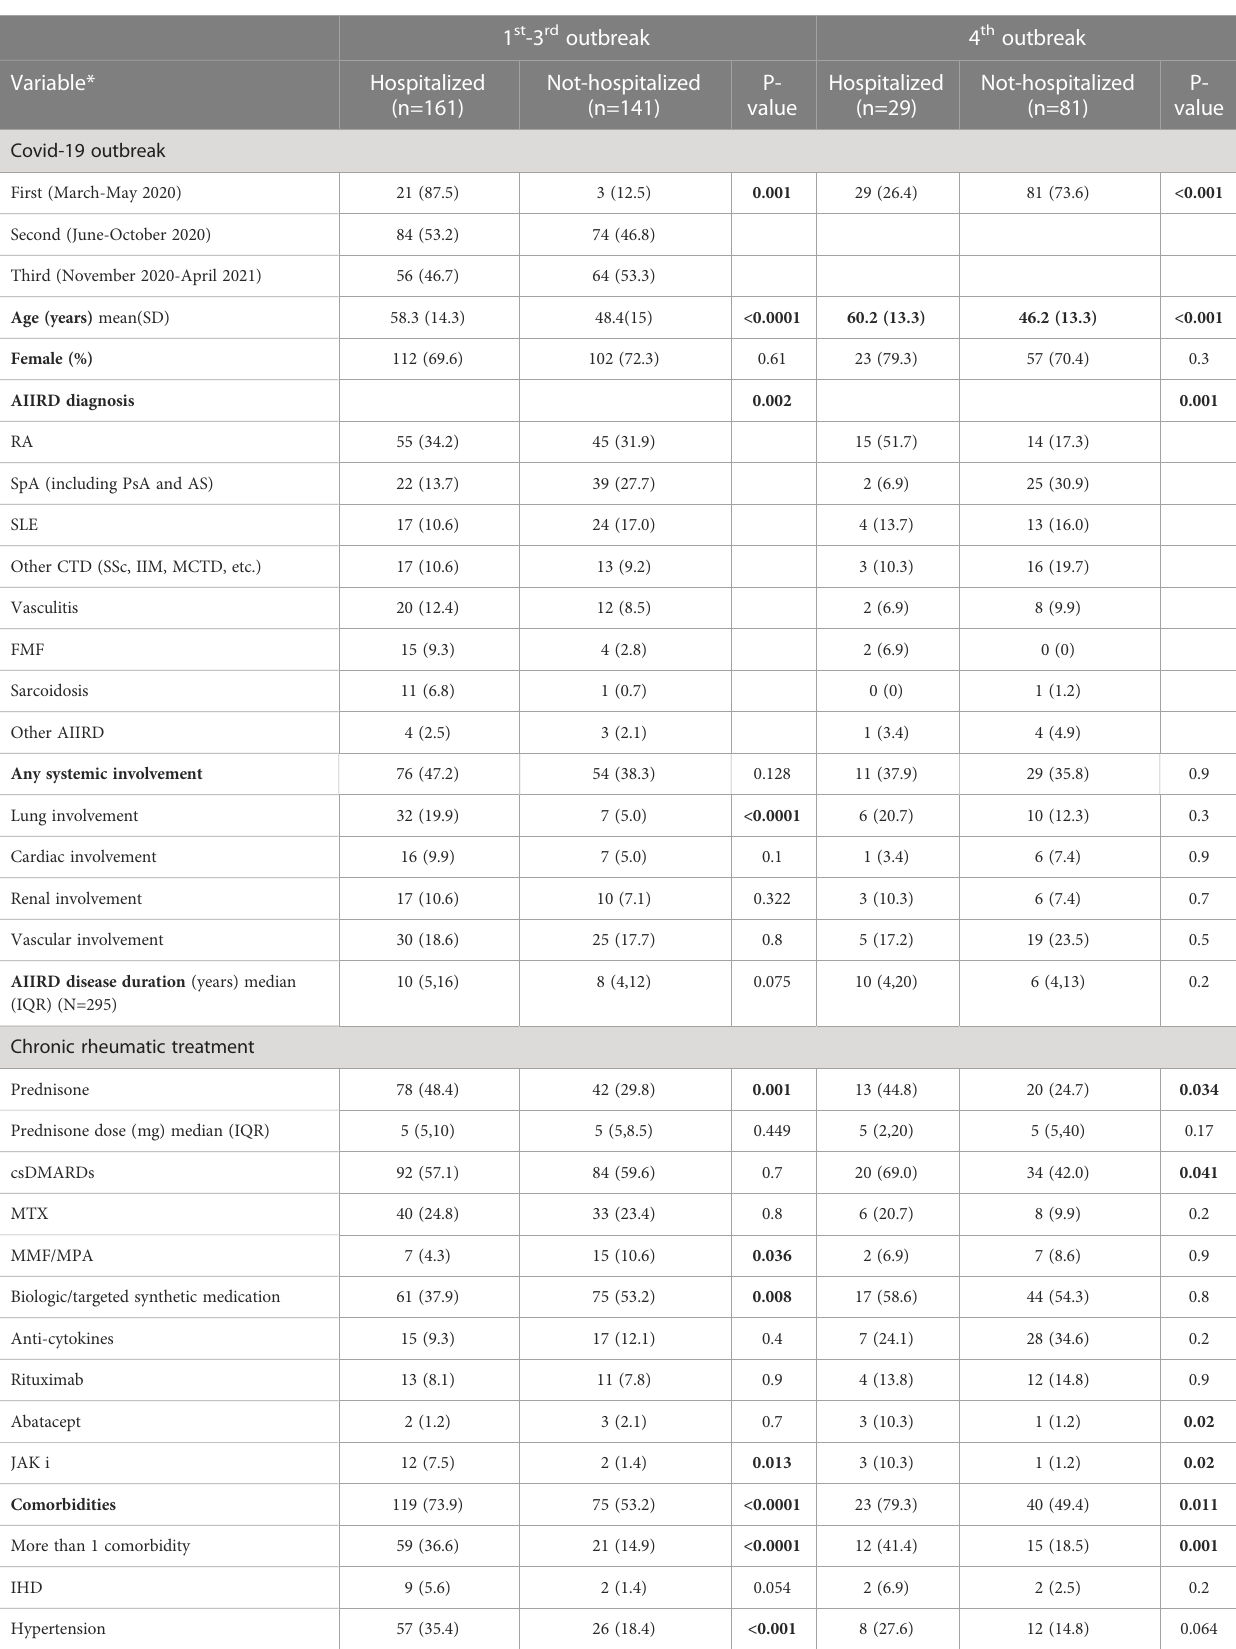
TABLE 4 Univariate analysis of demographic, clinical and COVID-19-related variables in regard to